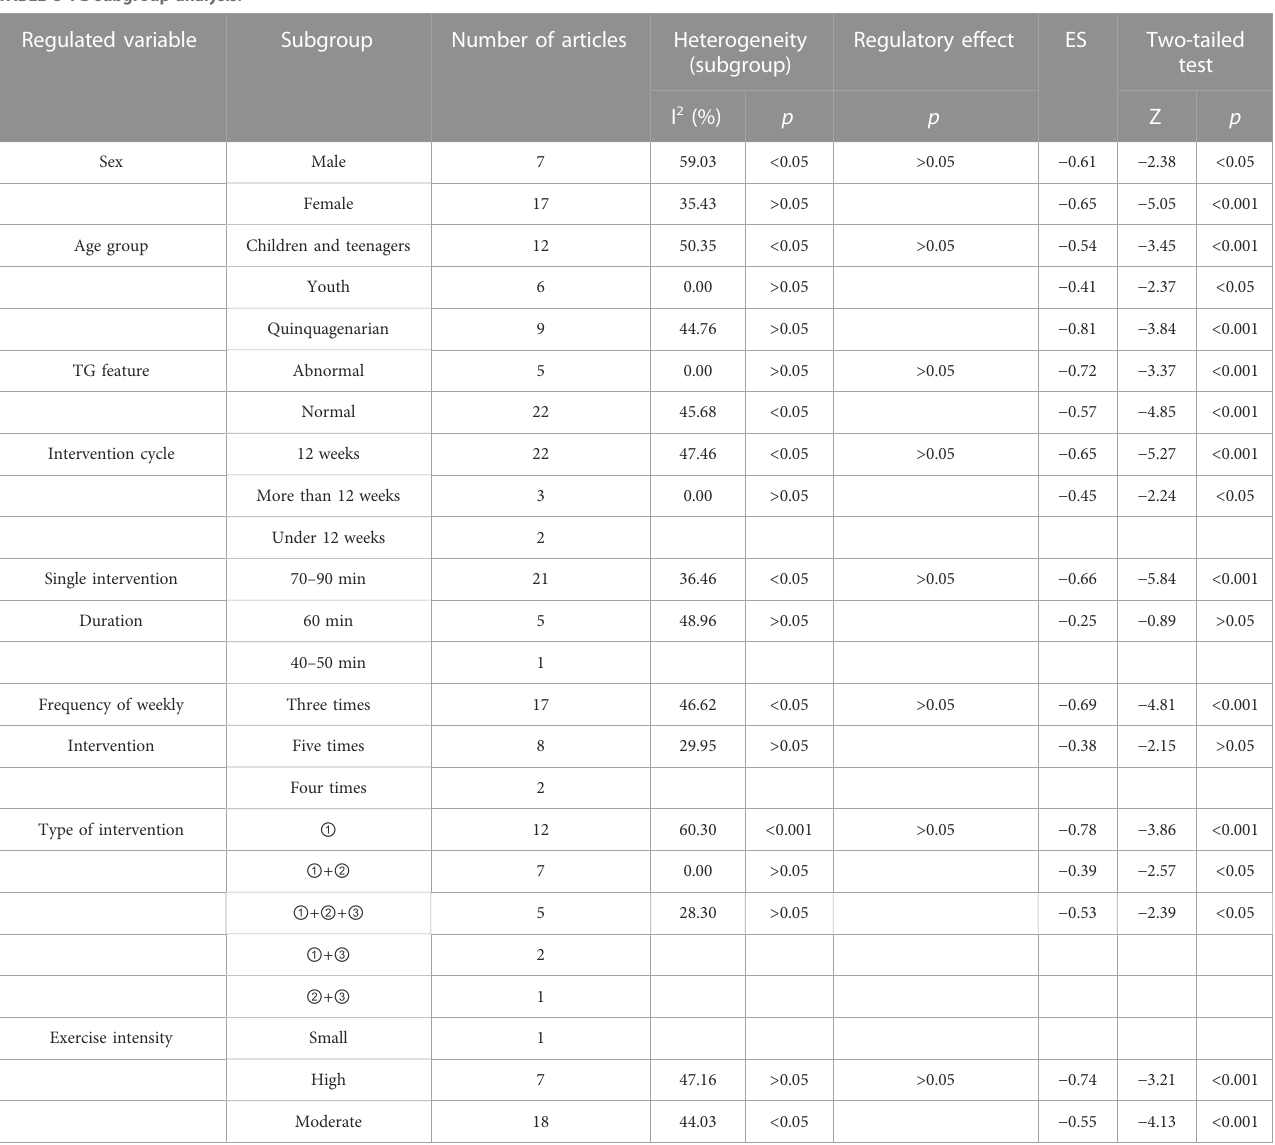
TABLE 8 TG subgroup